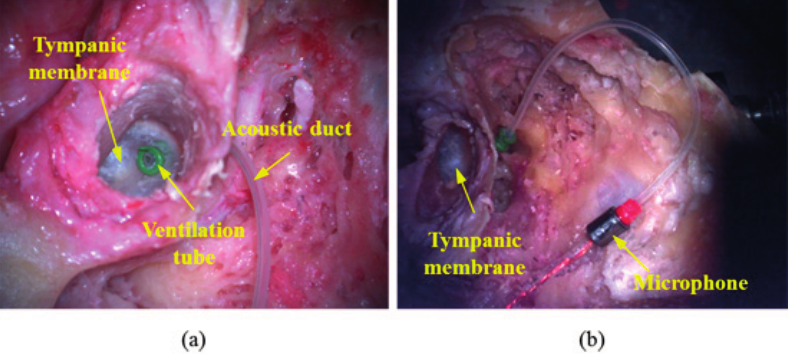
Figure 4. Photograph of installed microphone at the tympanic membrane and middle-ear cavity. ( a ) Front view of the tympanic membrane with installed ventilation tube; ( b )